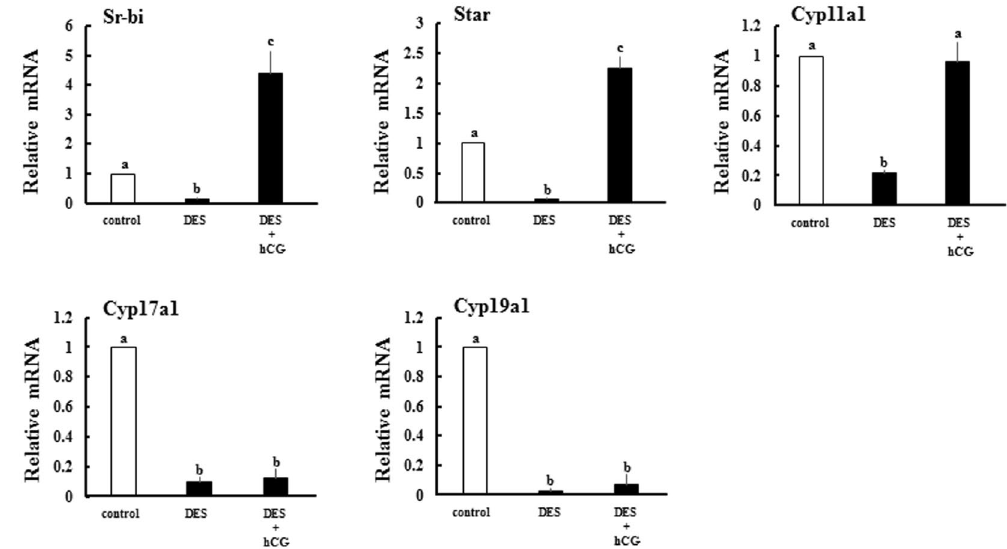
Figure 6. Effects of hCG on ovarian steroidogenesis-related gene expression in DES-treated animals. Steroidogenesis-related gene expression in ovaries from immature rats treated with vehicle, DES and hCG for 6 h. Expression of each gene was analyzed by Q-PCR and normalized to 36B4 expression. Q-PCR data represent the mean ± SEM of at least three independent samples. Values marked by different letters are significantly different ( P <